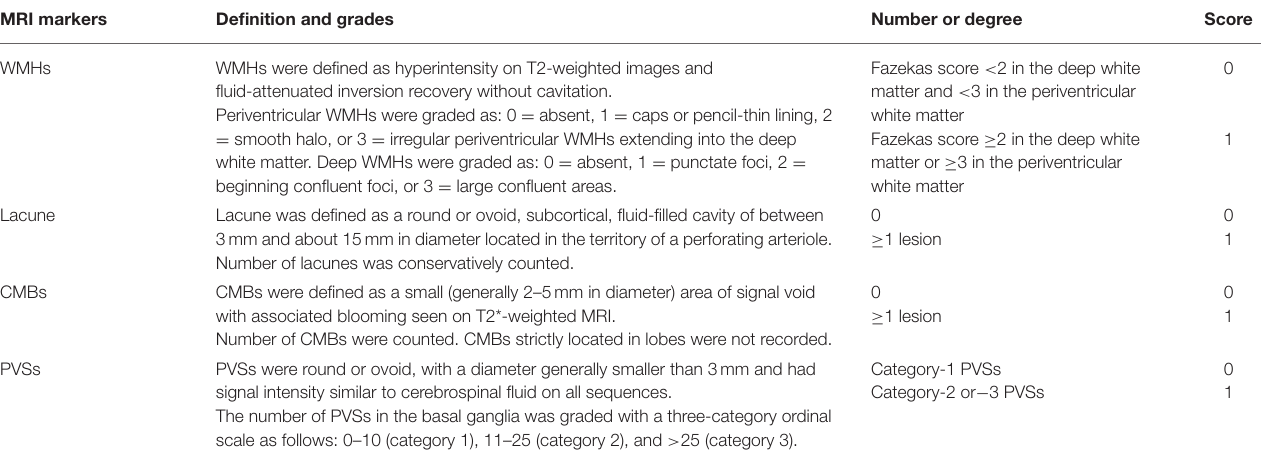
TABLE 1 | Evaluation criteria of the four cerebral SVD markers and the total cerebral SVD burden score. MRI markers Definition and grades Number or degree Score WMHs WMHs were defined as hyperintensity on T2-weighted images and fluid-attenuated inversion recovery without cavitation.